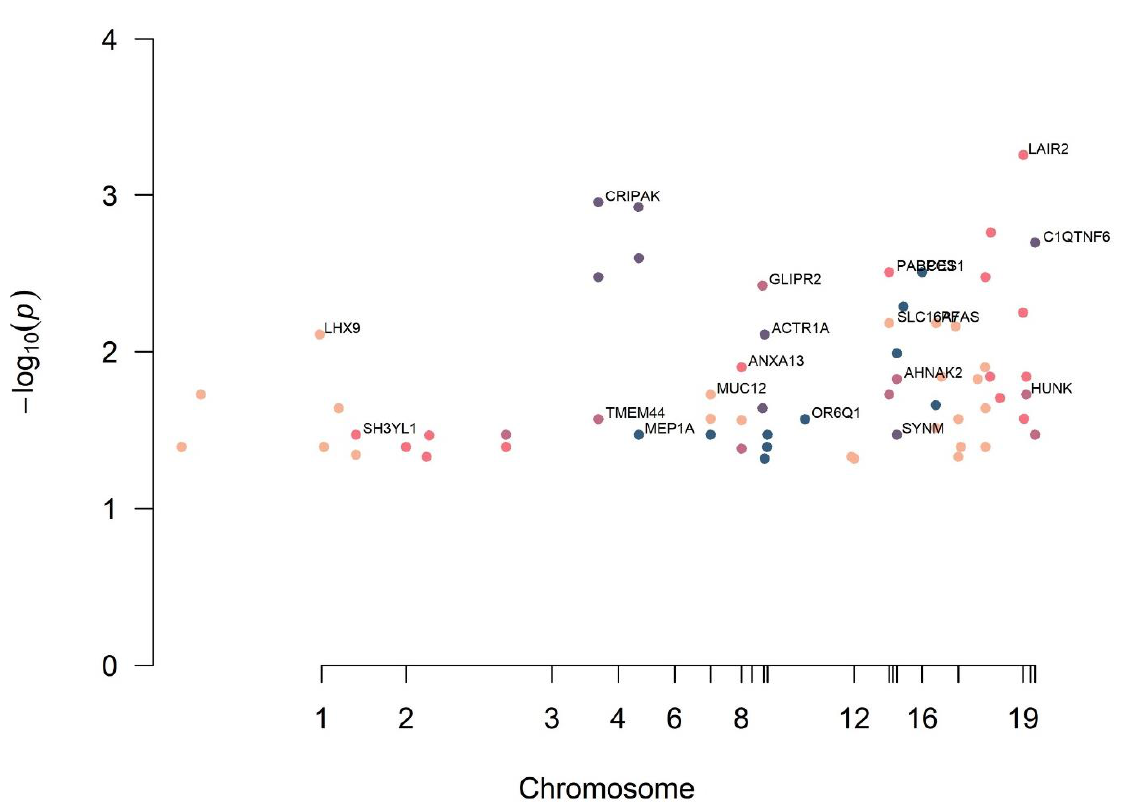
Figure 2. Manhattan plot of the results from the GWAS analysis of RC after filtering. The –log 10 p values for association with RC tear for filtered SNPs data from GWAS are plotted by genomic position with chromosome number listed across the bottom. The y-axis shows the –log 10 p values for association with RC tear. SNPs with the lowest p values in each chromosome are annotated with the nearest gene name. All data met genome-wide significance criteria with a p -value of less than 0.05.